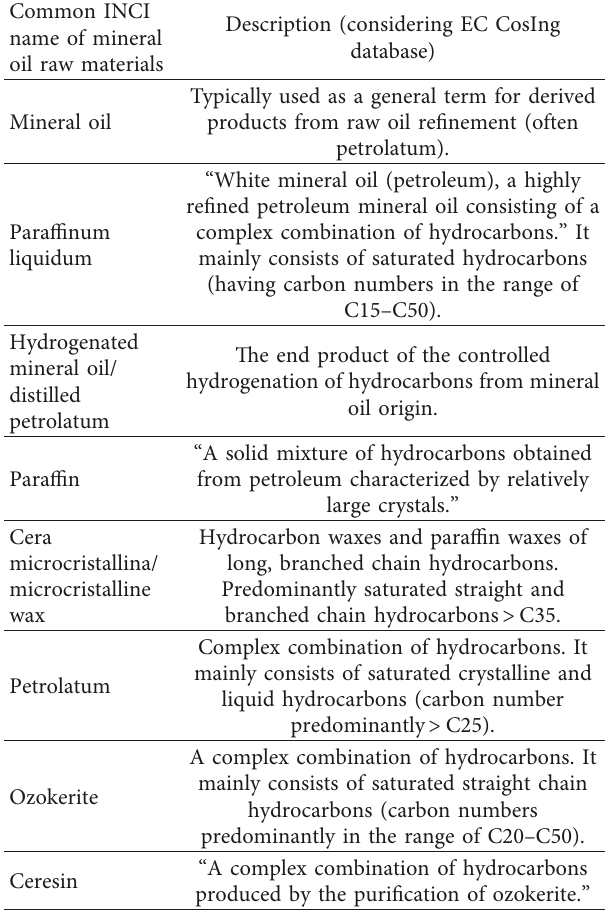
Table 1: Classification of mineral oil raw materials according to their